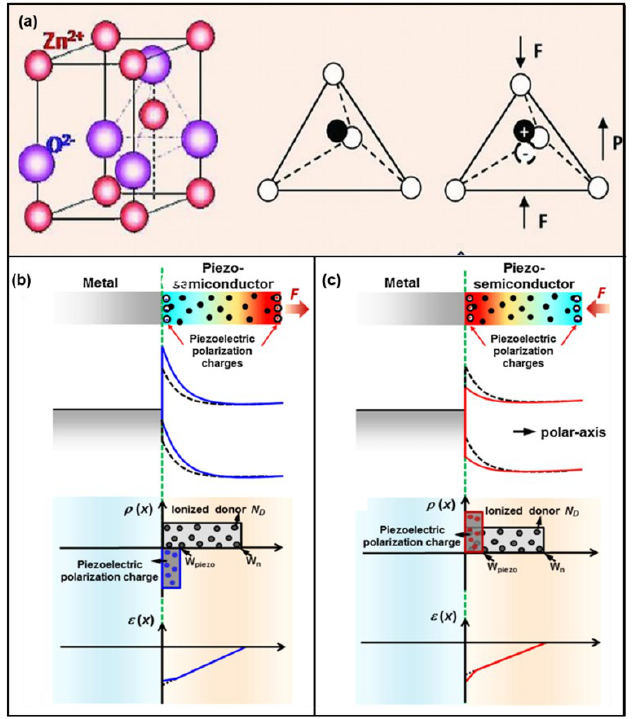
Figure 1. ( a ) Atomic model of the wurtzite-structured ZnO. Reproduced with permission from [40]. Copyright (2012) Advanced Materials . The energy band diagram, spatial charge distribution, and electric field schematics where ( b ) tensile strain is applied and ( c ) compressive strain is applied. Reproduced with permission from [61]. Copyright (2013) Nano Today .